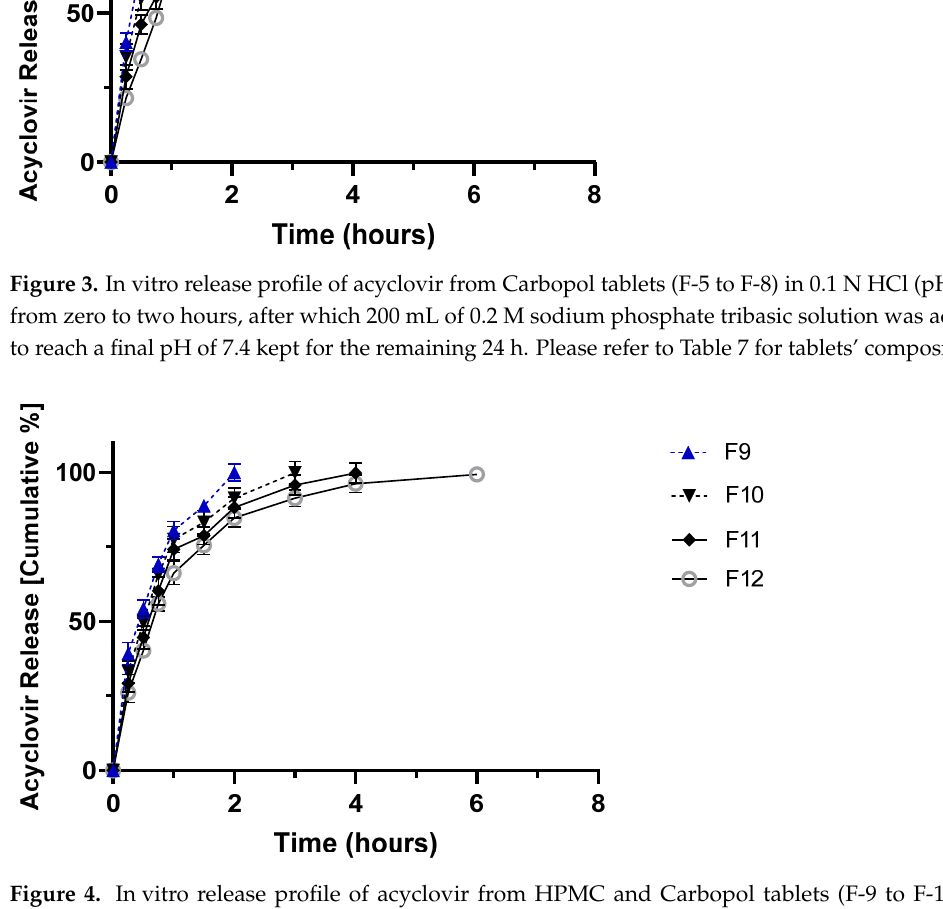
Figure 4. In vitro release profile of acyclovir from HPMC and Carbopol tablets (F-9 to F-12) in 0.1 N HCl (pH 1.2) from zero to two hours, after which 200 mL of 0.2 M sodium phosphate tribasic solution was added to reach a final pH of 7.4 kept for the remaining 24 h. Please refer to Table 7 for tablets’ composition.